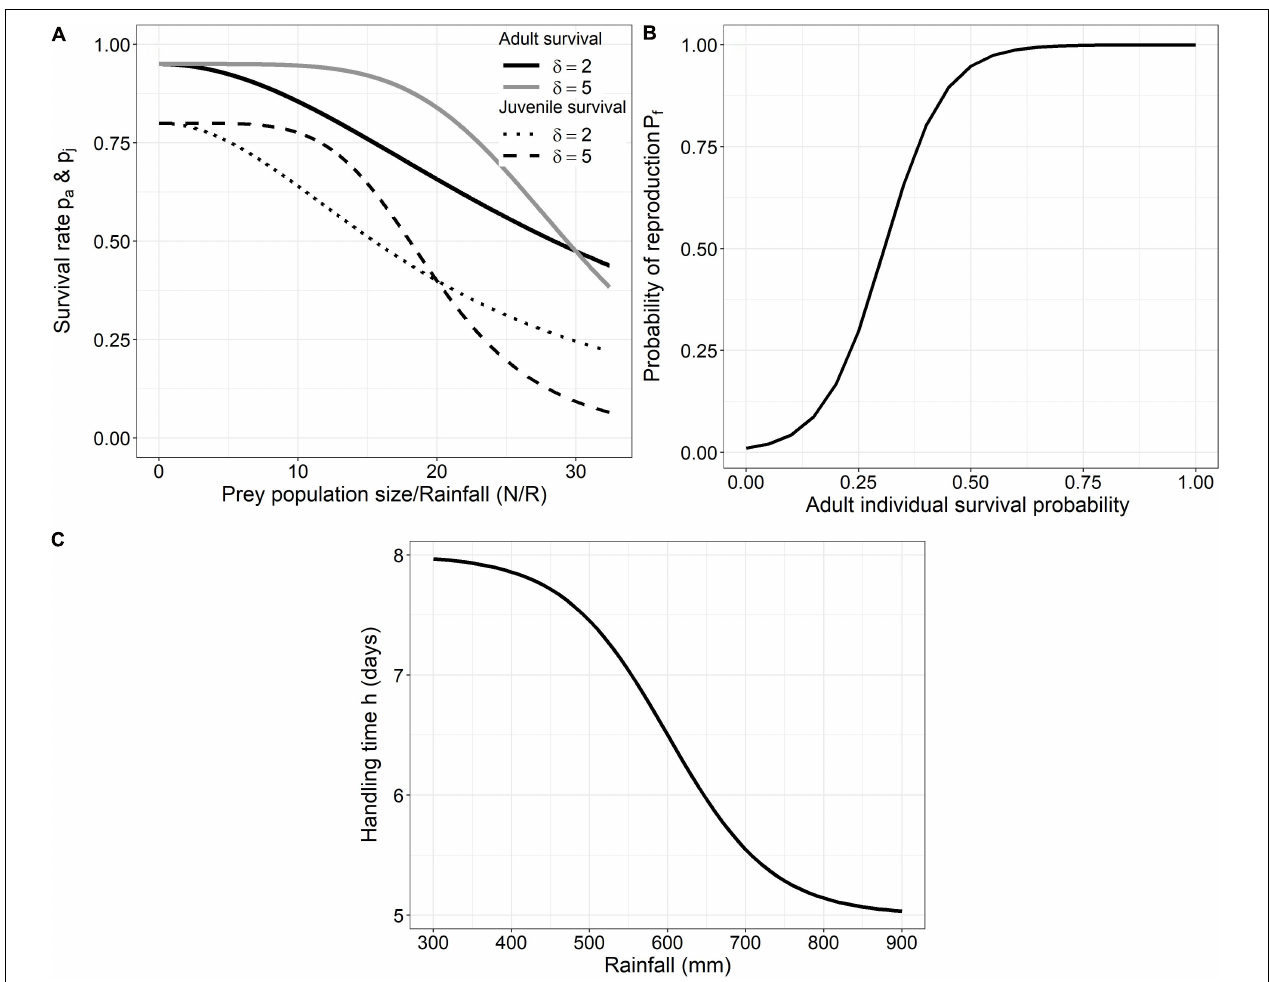
FIGURE 2 | Summary of the functional relationships underlying the model. (A) Effect of increased number of individuals per resource unit (approximated by rainfall) on mean juvenile and adult prey survival rates adapted from Wilmers et al. (2007a). Mean adult and juvenile prey survival rates has been represented for two values of δ parameter, which controls the onset and the strength of the density dependence. Juvenile prey survival rate has been set to be the first impacted by increasing density. (B) Probability of reproduction as a function of survival probability p ai ( t ). (C) Functional relationship between rainfall and predator handling time h as defined by Eq. 5 for parameters given in Table 1 . The hunting success varies inversely with the handling